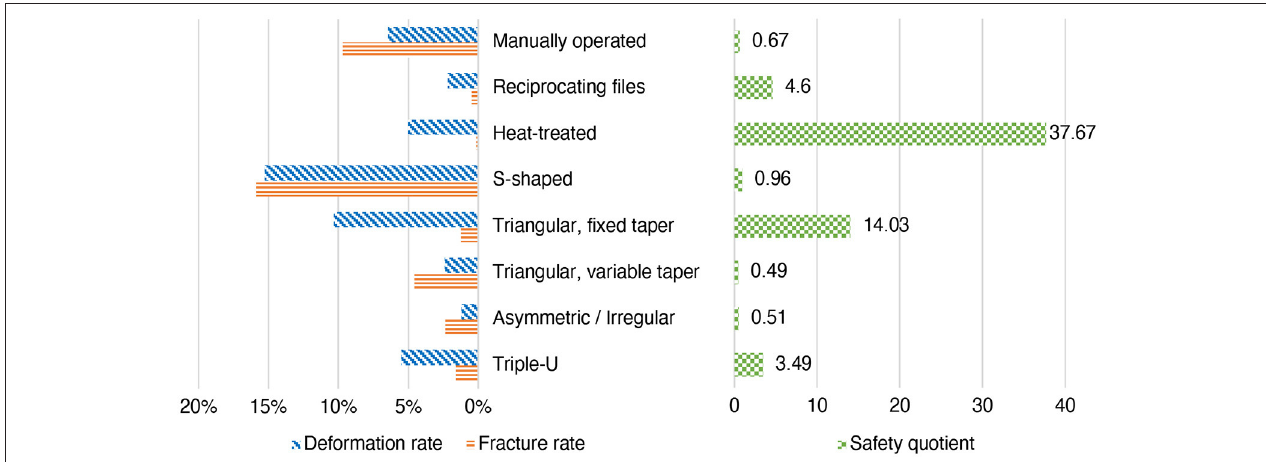
FIGURE 4 | Proportion of single- vs. multiple use instruments showing plastic deformation or distorted flutes only (i.e., deformation rate) and those reported to have separated (i.e., fracture rate); and the calculated safety quotient values for various instrument types.